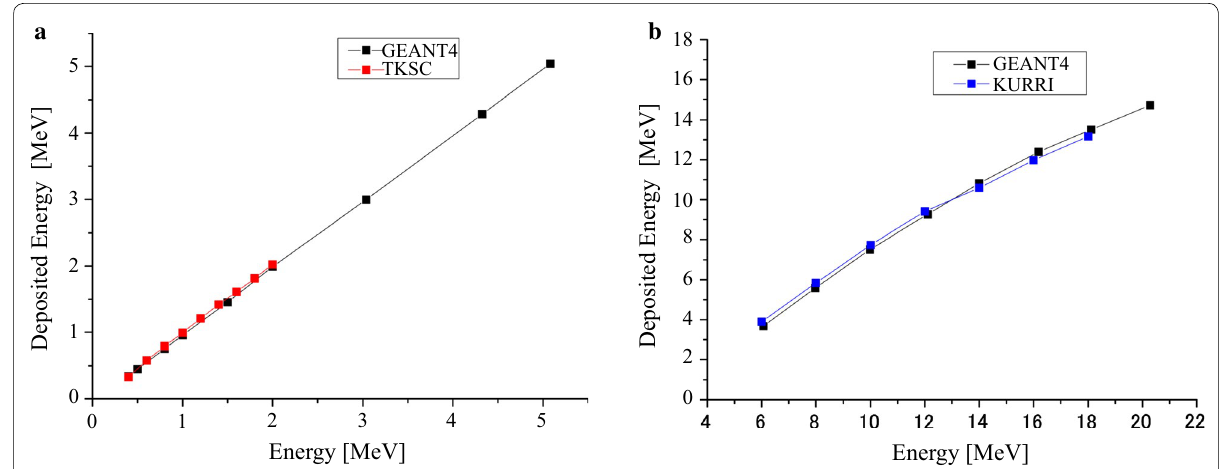
Fig. 7 The deposited energies converted from the ADC channels obtained by the irradiation tests and the deposited energies estimated by the GEANT4 simulation are plotted. a The results of the irradiation tests for 0.4–2 MeV electrons at TKSC (red line) and the GEANT4 simulation results for 0.5–5 MeV electrons (black line). b The results of the irradiation tests for 6–18 MeV electrons at KURRI (blue line) and the GEANT4 simulation results for 6–20 MeV electrons (black